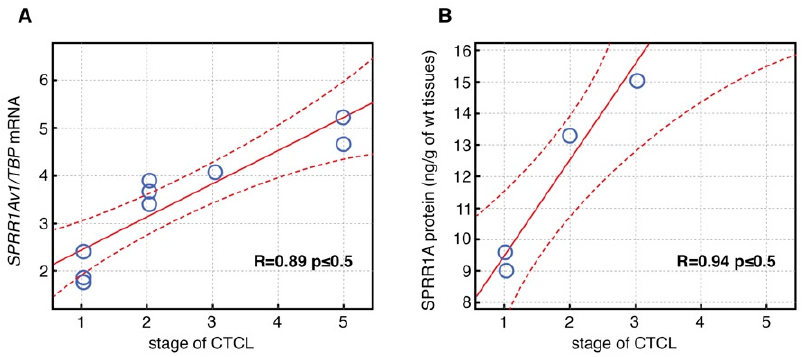
Figure 3. Correlation of SPRR1Av1 gene expression at both mRNA ( A ) and protein levels ( B ) with stage of